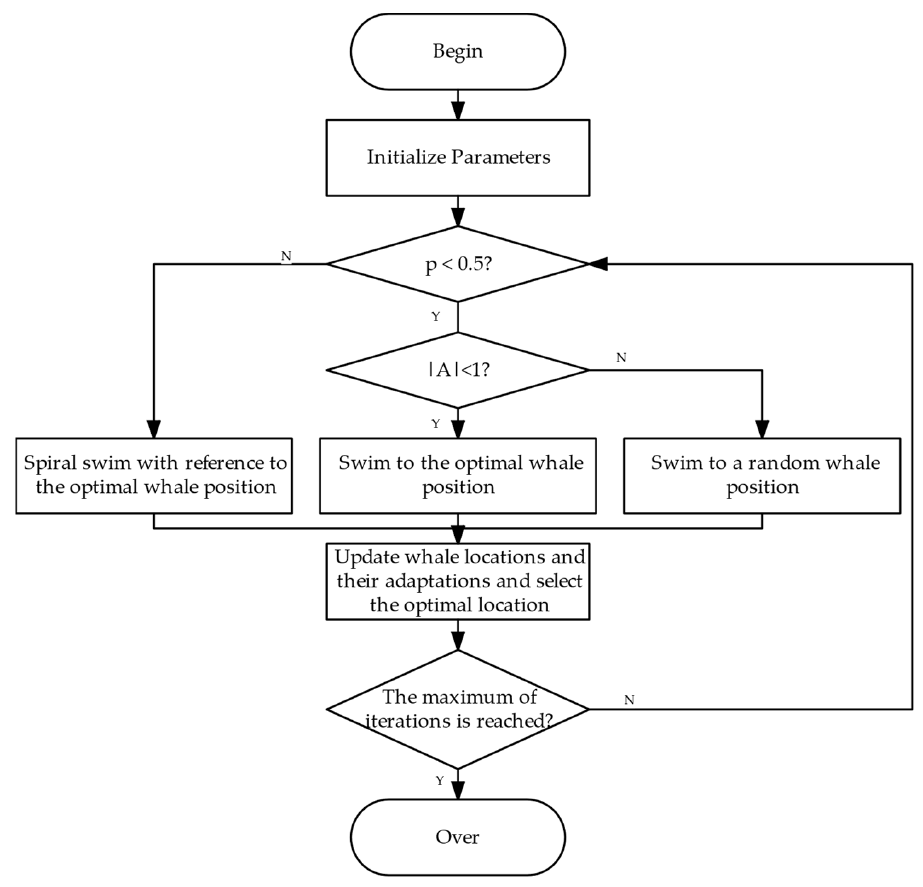
Figure 5. Algorithm fl owchart of WOA.